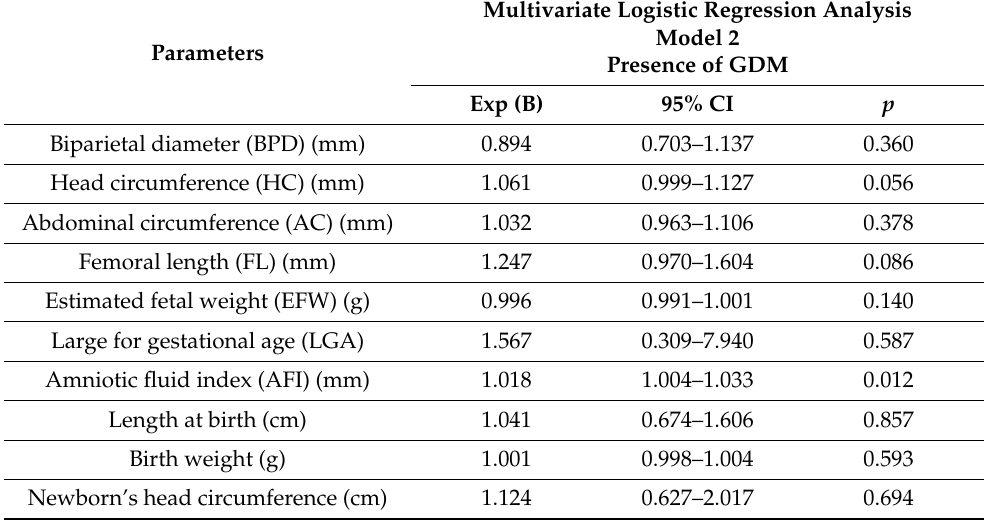
Table 5. Multivariate regression analysis of fetal and newborn perinatal parameters due to the presence of GDM ( N =